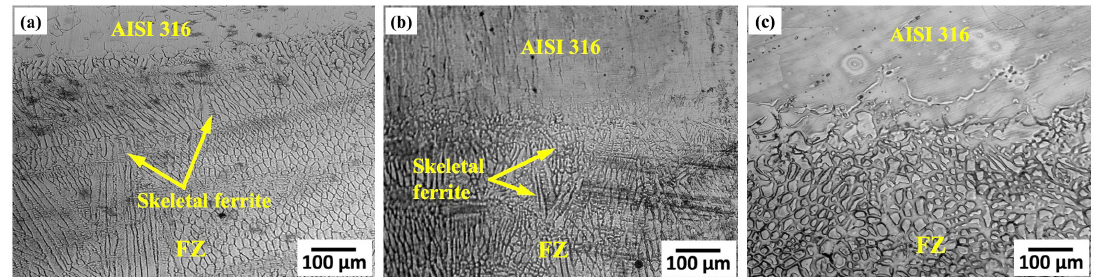
Figure 8. Microphotography of areas at the weld centreline with different welding conditions (a) 600A, 0.3s, no Ni (b) 600A, 0.3s, with Ni (c) 800A, 0.3s, with Ni.